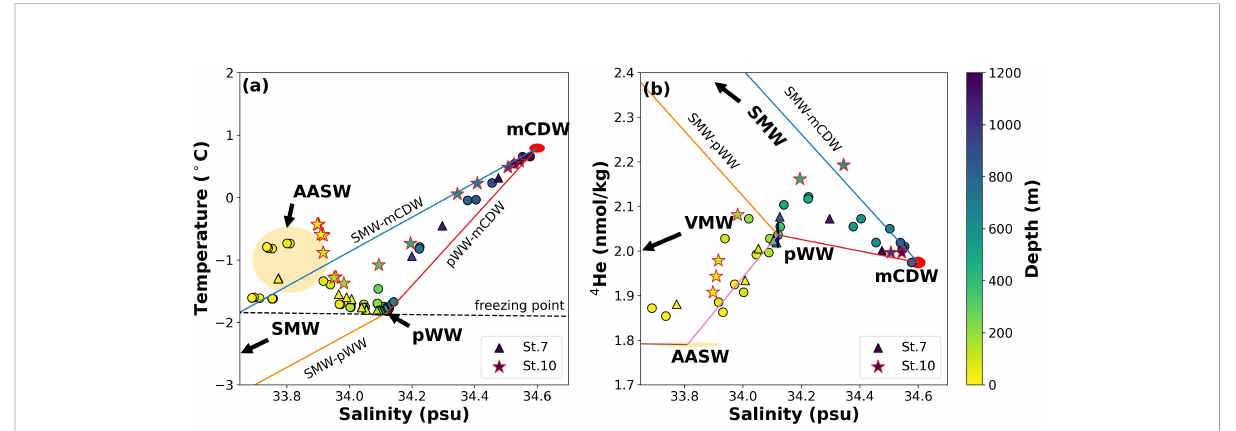
FIGURE 3 Bivariate plots of (A) potential temperature − salinity and (B) 4 He − salinity. The circles, triangles, and stars represent samples collected in the DGT. Many samples in the shallow layer ( ≤ 200 m) plot above the line of binary mixing between mCDW and SMW in (A) . These samples plot along the line of binary mixing between pWW and AASW in (B) , suggesting that AASW is necessary as an additional source water for NG-OMPA. The orange and red shades represent the variabilities of AASW and mCDW,